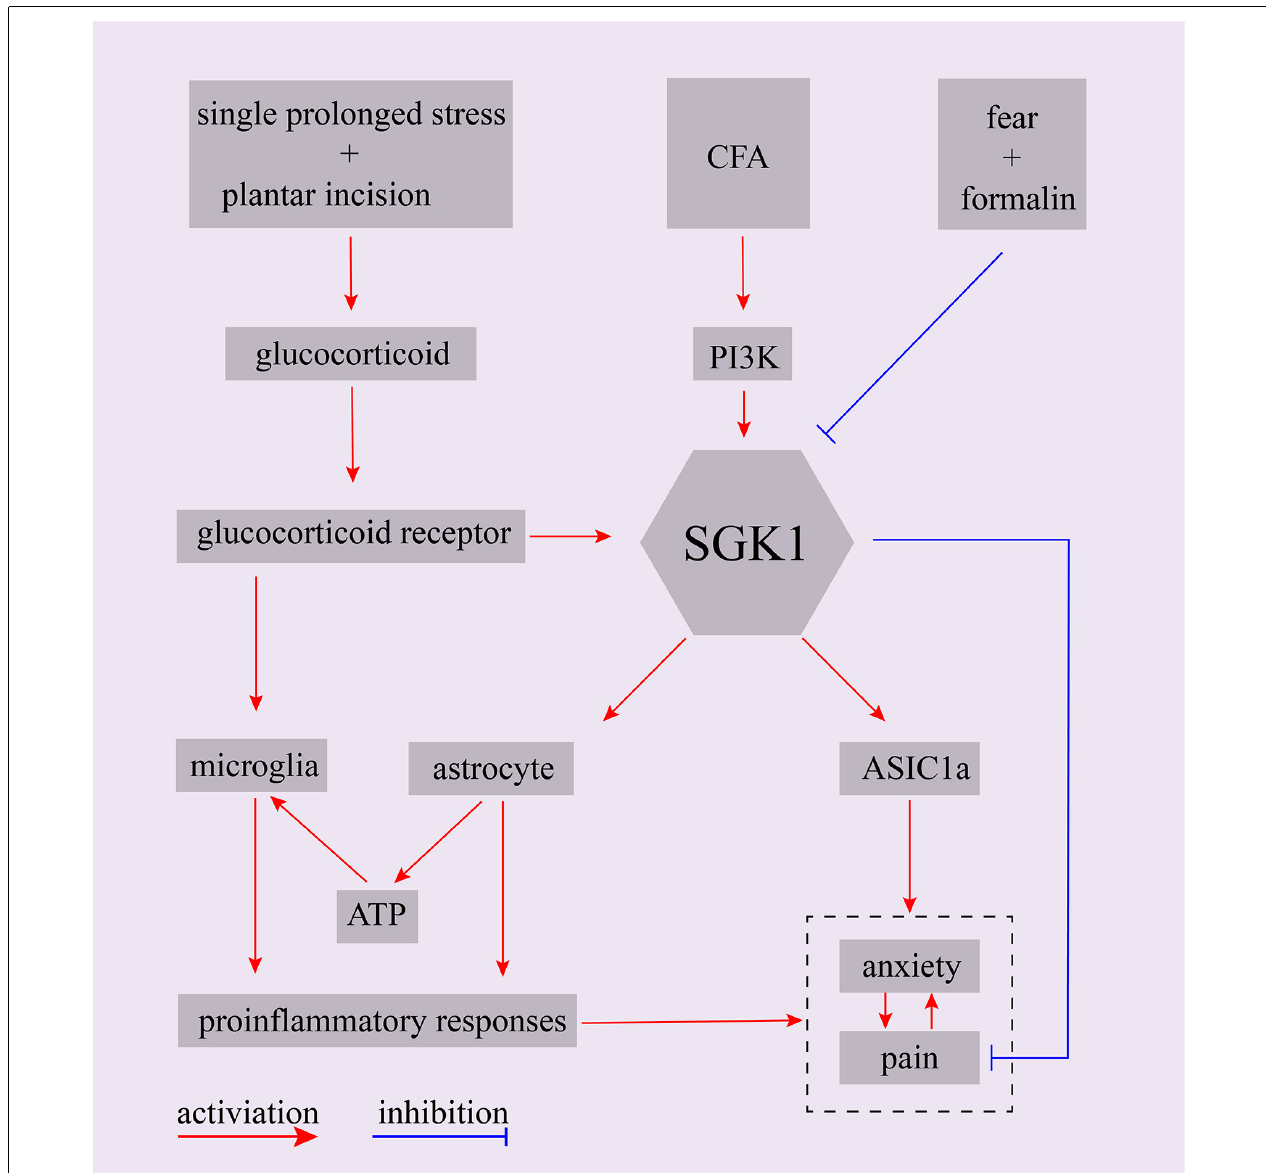
FIGURE 4 | Schematic representation of potential role of SGK1 in the interaction between emotion and pain. CFA, complete Freund’s adjuvant; PI3K, phosphoinositide 3-kinase; SGK1, serum- and glucocorticoid-inducible kinase 1; ASIC1a, acid-sensing ion channel